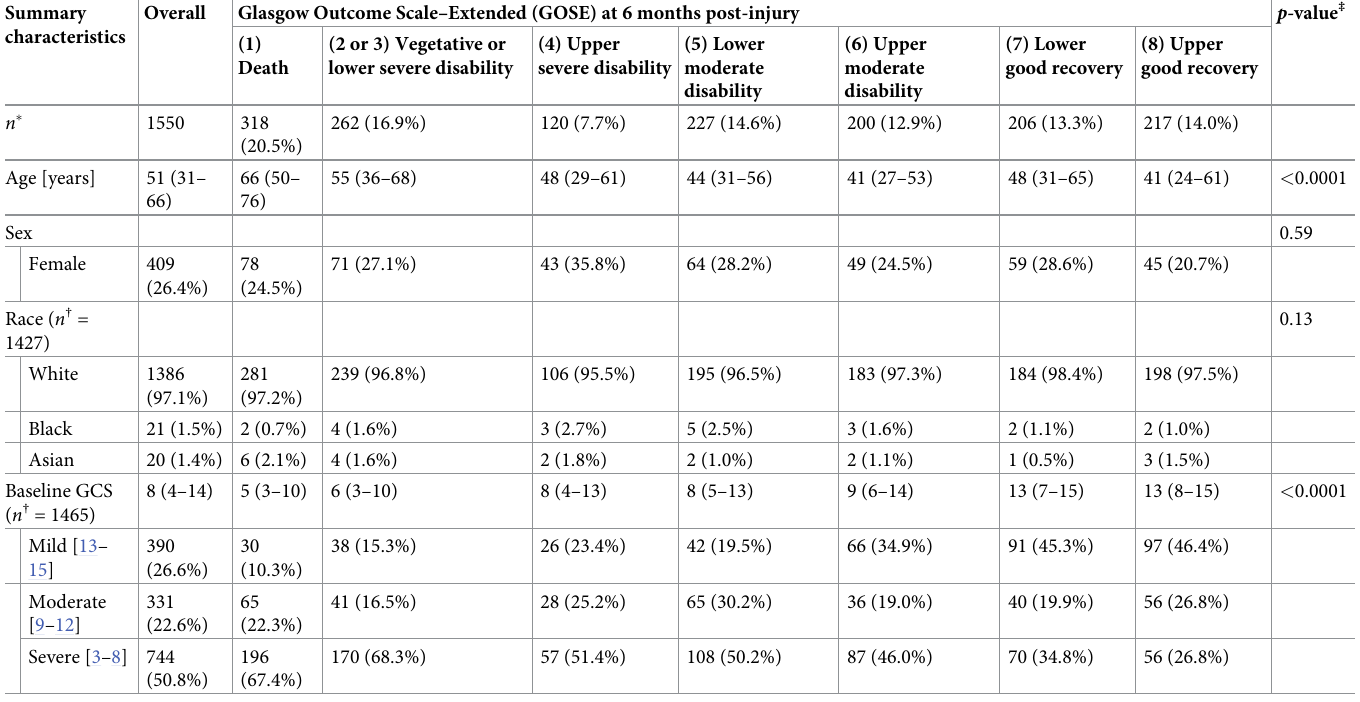
Table 1. Summary characteristics of the study population at ICU admission stratified by ordinal 6-month outcomes. Summary characteristics